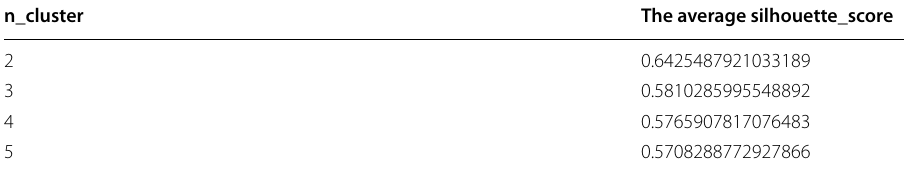
n_cluster The average